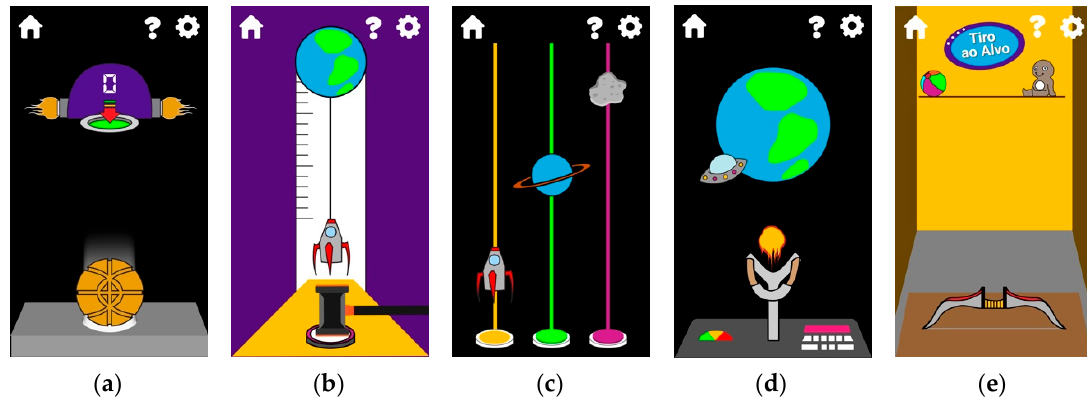
appears on the screen and the second tap chooses the strength and launches the spaceship (Figure